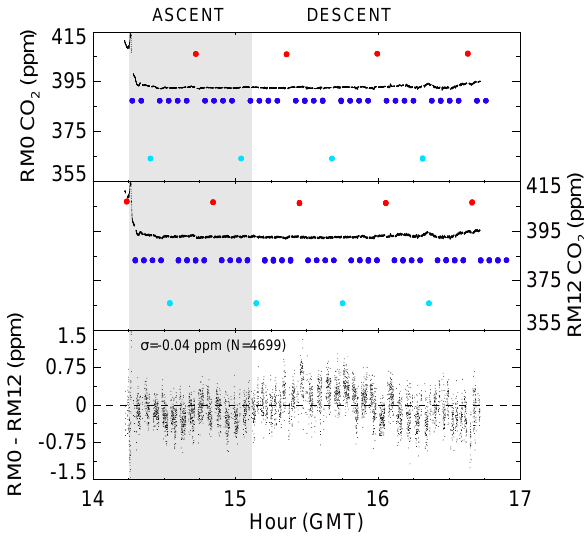
Fig. 4. CO 2 mole fraction collected on 21 March 2011 by the two continuous analyzers. Top and middle panels show observations by RM0 and RM12, respectively, organized by ascent and descent. Red circles give target, dark blue circles give zero, light-blue circles give responsivity, and black dots give unknown sample measurements (1Hz). The bottom panel shows the mean difference ( − 0.04ppm) between CO 2 mole fraction measured using the two continuous sys-